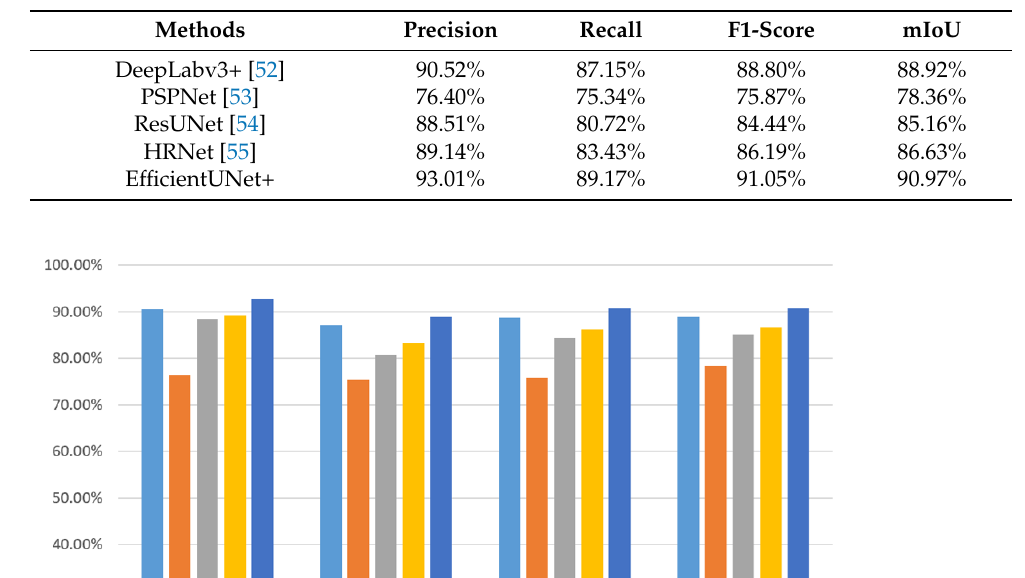
Table 3. Accuracy comparison of the extraction results of different methods.